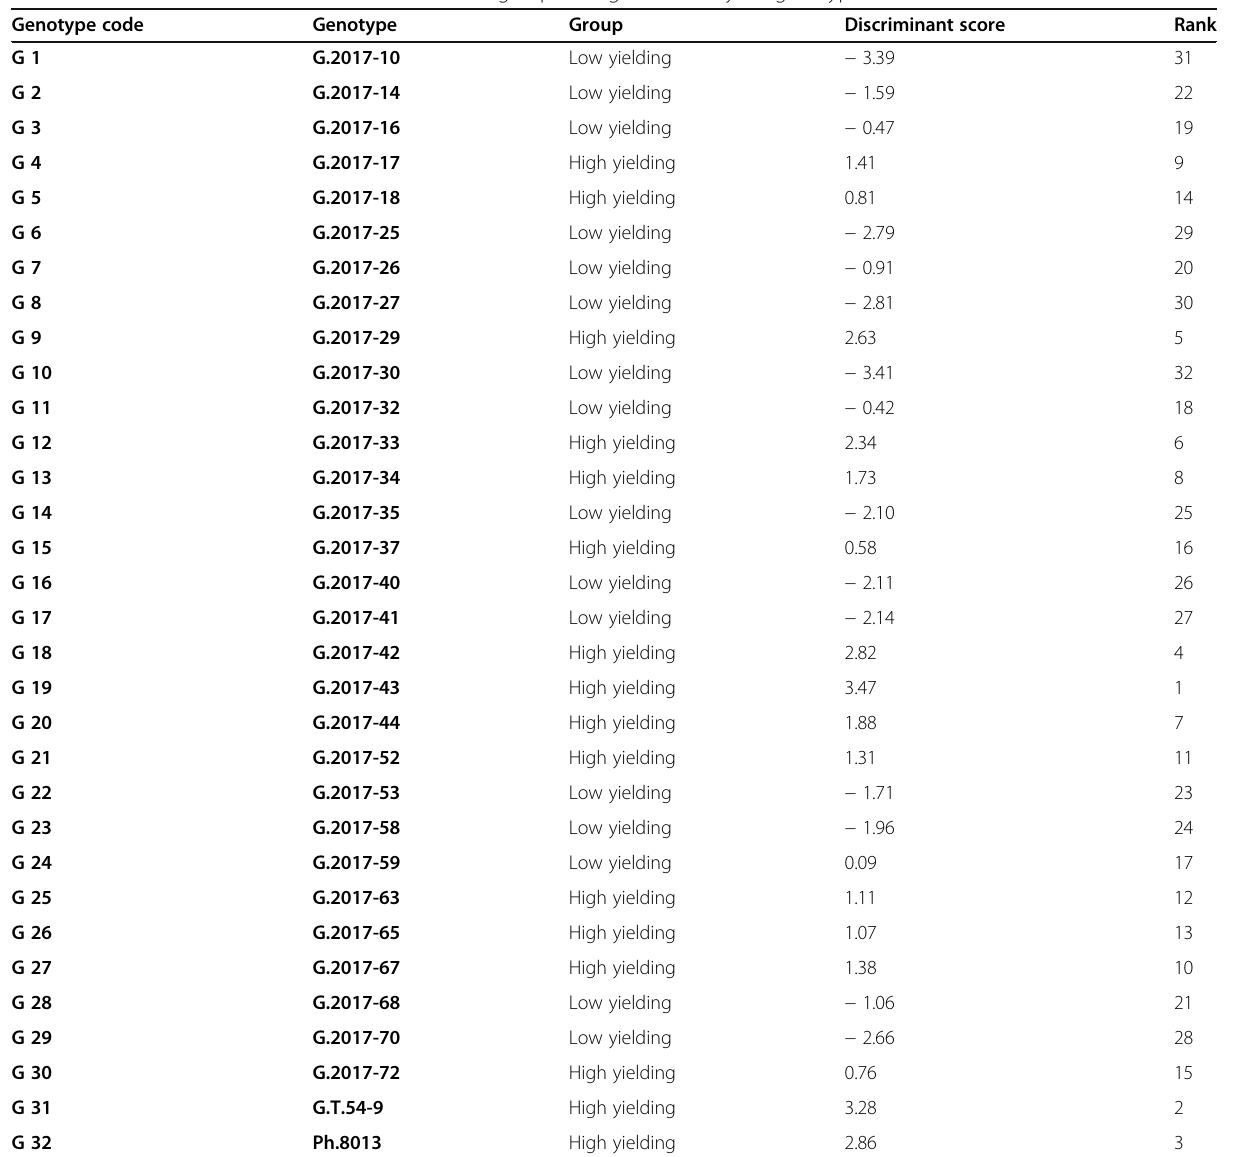
Table 8 Discriminant score and classification for two groups of high- and low-yield genotypes Genotype code